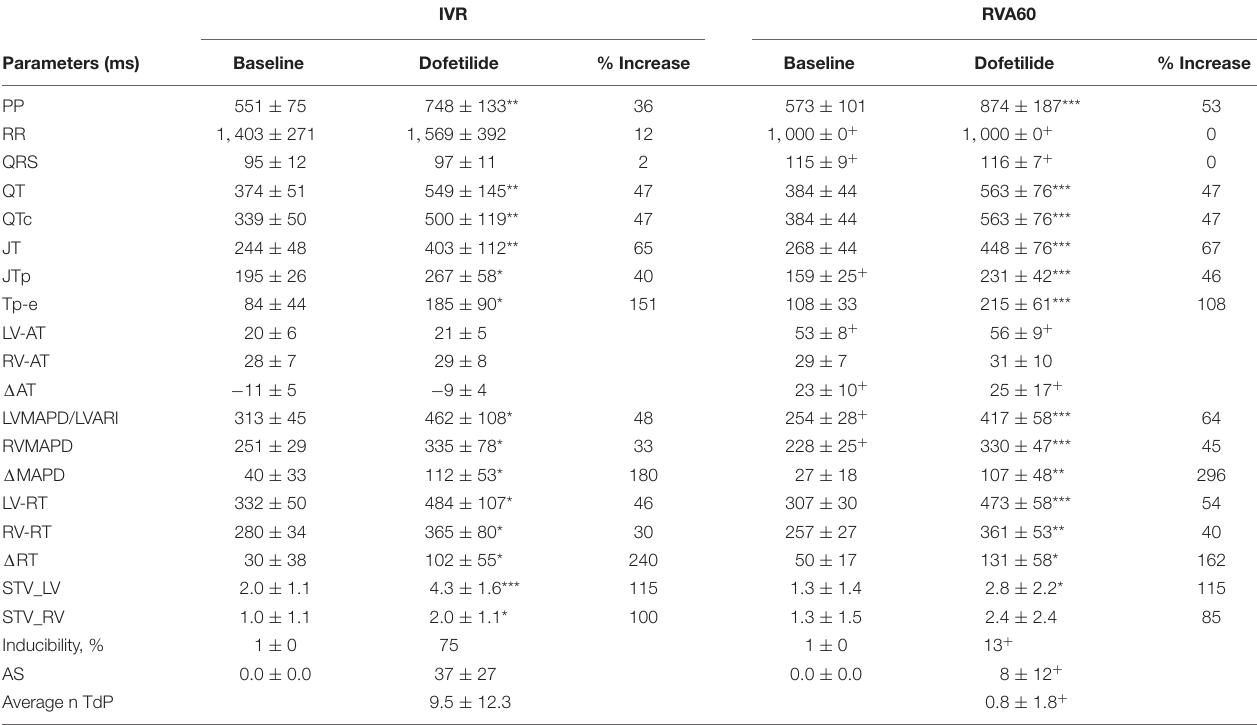
TABLE 1 | Serial comparison of the electrophysiological effects of IVR and acute RVA60 conditions in baseline and following dofetilide administration (both groups n = 8).